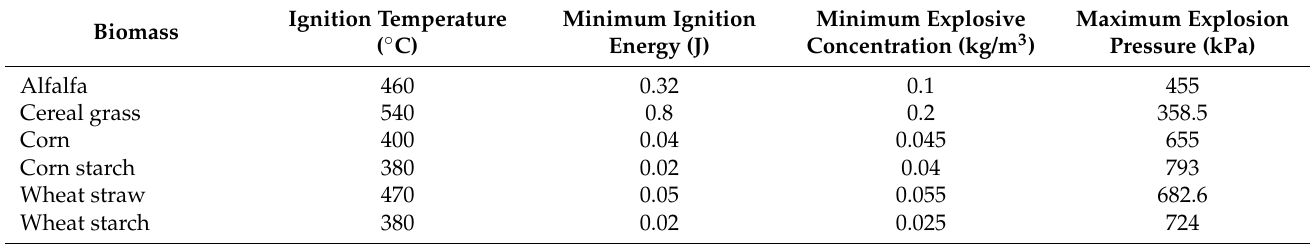
Table 7. Explosibility of agricultural dust